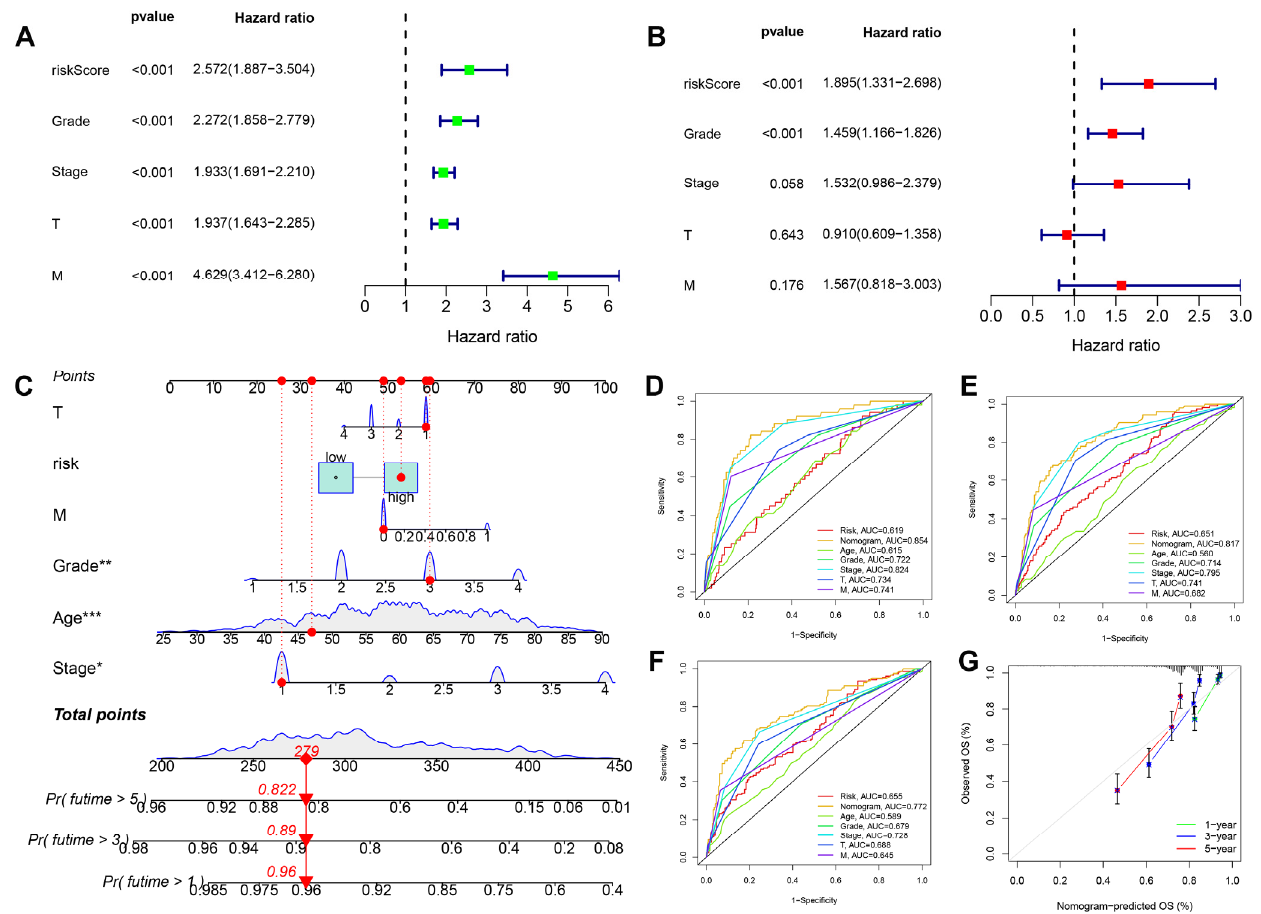
Figure 5. Construction of related immune escape nomogram. ( A , B ) Univariate and multivariate cox regression analysis of the prognostic significance of IE scores, grade, stage, T stage and M stage of tumors. ( C ) Construction of a nomogram related to immune escape (*: p < 0.05; **: p < 0.01; ***: p < 0.001). ( D – F ) ROC curve of IE score, nomogram, age, grade, stage, T and M in 1 year, 3 years, and 5 years. ( G ) Calibration Chart for testing the accuracy of nomogram in predicting the overall Survival time of ccRCC patients.